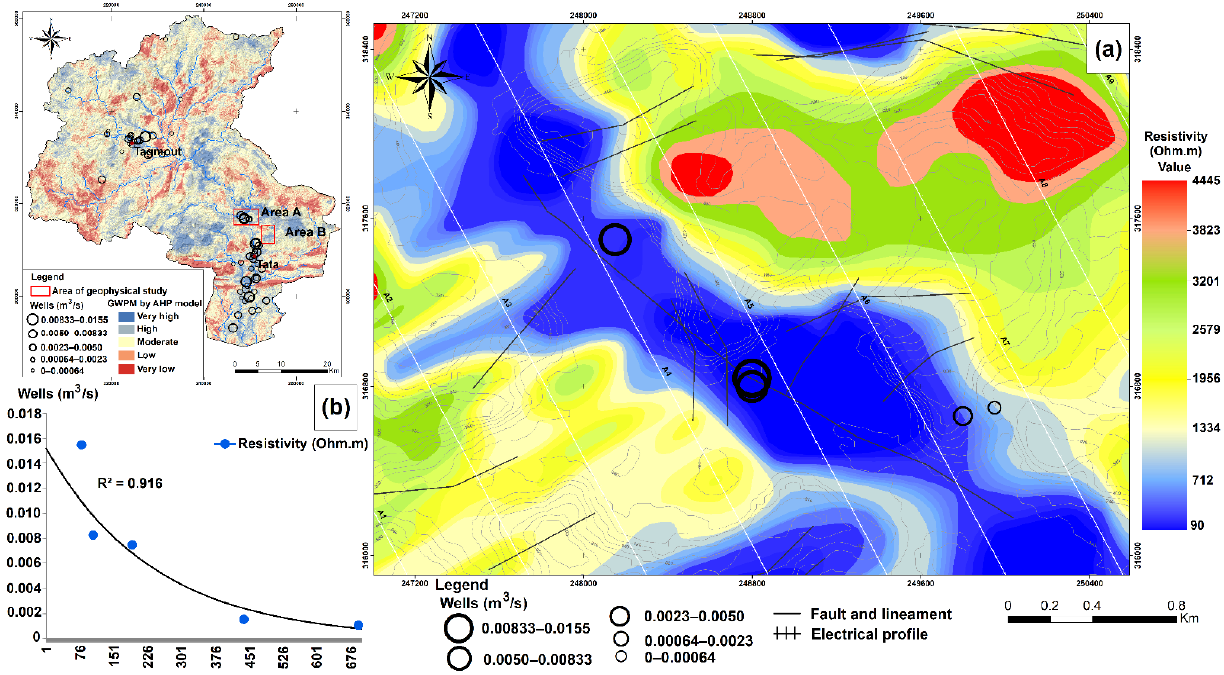
Figure 9. ( a ) Variation map of apparent resistivities in Ohm.m in area A deduced from the electrical traces for a length AB = 300 m and ( b ) correlation between apparent resistivity values in Ohm.m and flow rates in m 3 /s of the wells in area A.